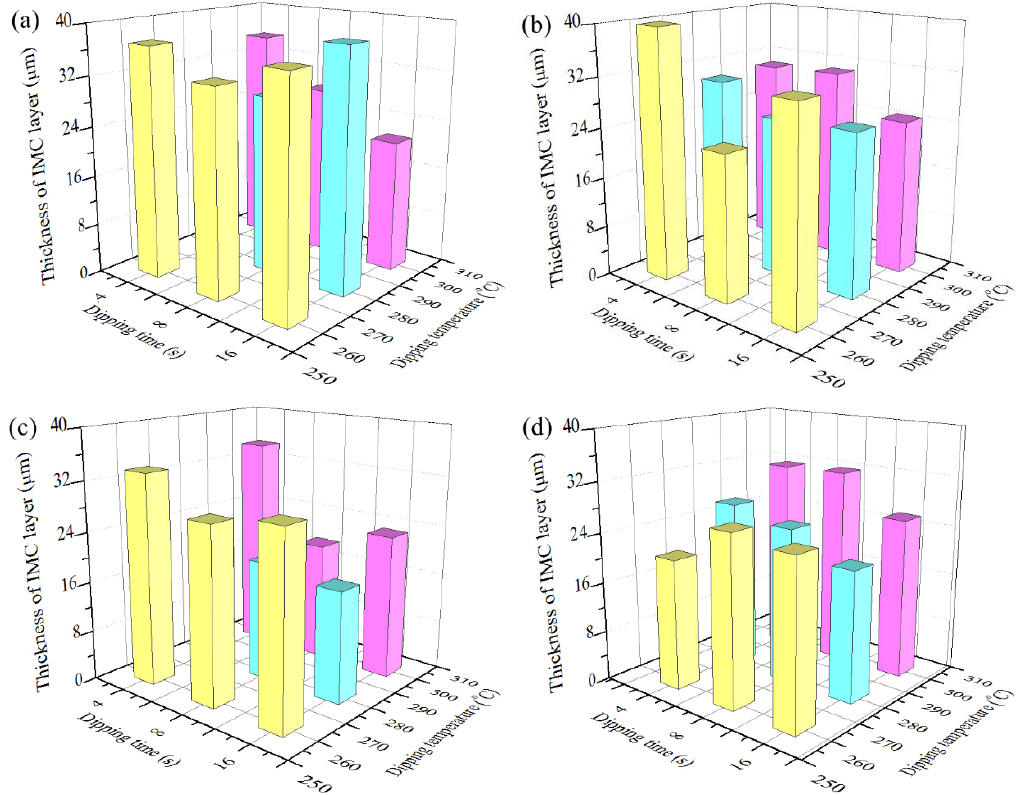
Figure 6. Variation of coating thickness with dipping temperature and dipping time for different types of copper foils: ( a ) C70250 foils, ( b ) C19400 foils, (c) C19210 foils, and ( d ) C11000 foils.